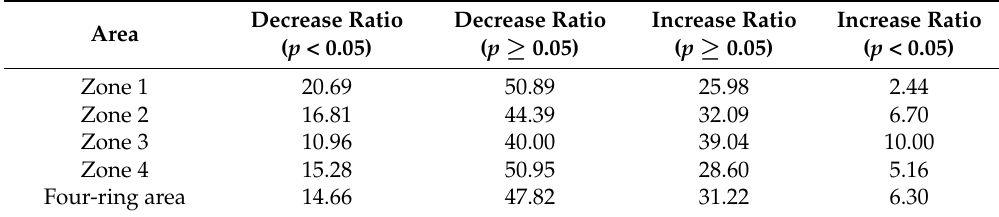
Figure 6. Classification of direct runoff trends at five percent significance level. Table 6. Area ratio of direct runoff trend by